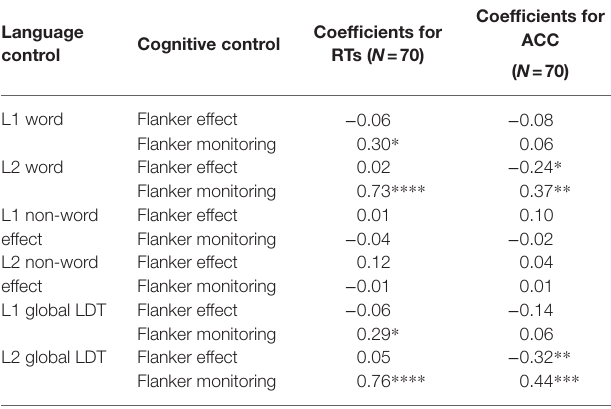
TABLE 8 | All bilinguals’ Pearson correlations between language control measured by the lexical decision task (LDT) and cognitive control measured by the flanker task at the dimension of response times (RTs) and accuracy rates (ACC).